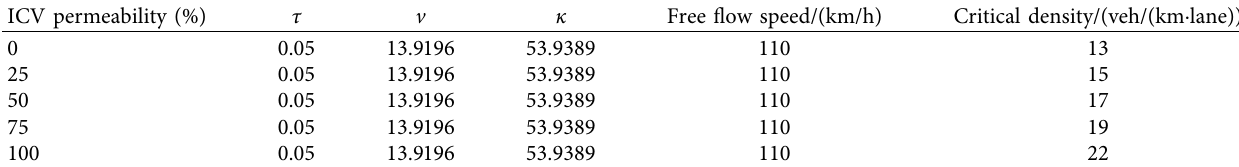
Table 7: Parameter calibration results.